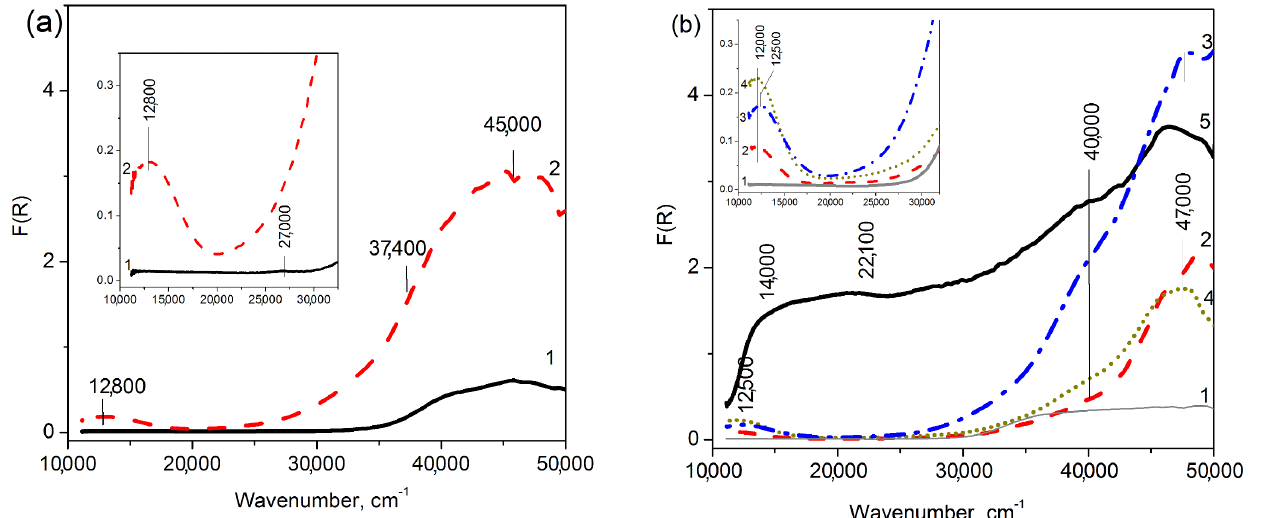
Figure 6. UV-Vis DR spectra of Cu-containing MFI ( a ) and ZSM-5 ( b ) prepared by the ion-exchange (2, 3) and incipient wetness impregnation (4, 5). The copper loadings are 0 (1), 2.0 (2, 4), 2.7 (3) and 16.0